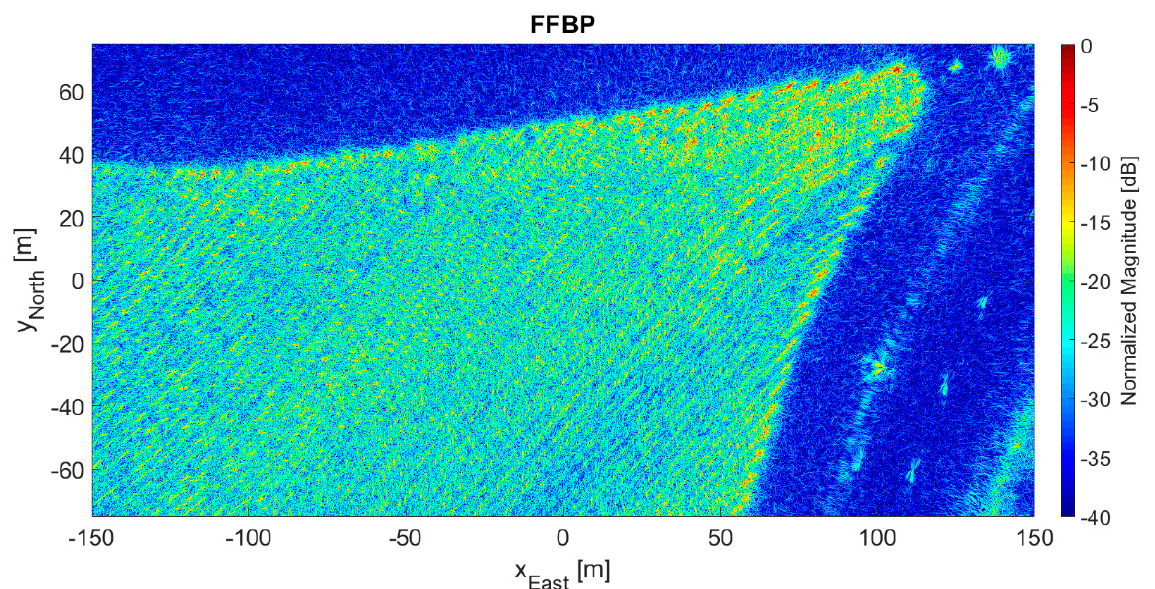
Figure 12. 2D output image processed by the FFBP algorithm with 𝐿 = 5 and an (8 × 4 × 1) initial partition.